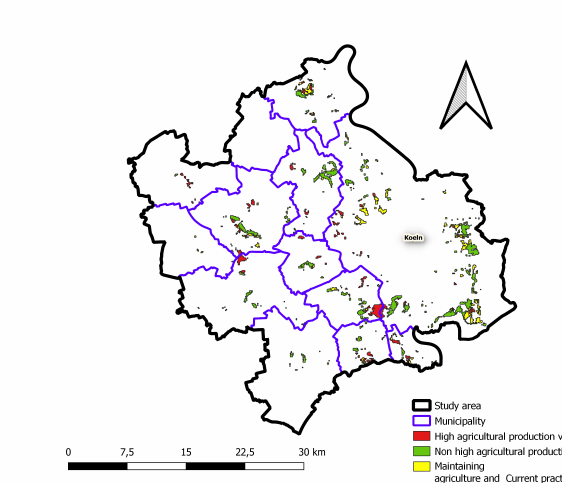
Figure 4. Additional residential areas allocated in the two